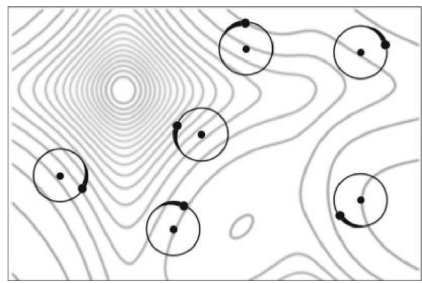
Figure 3: State diagram of atom spreading.